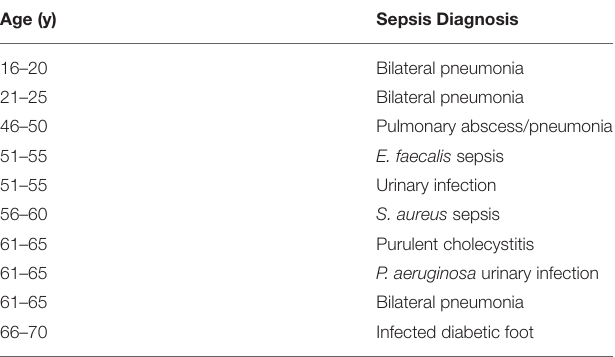
TABLE 4 | Clinical and laboratory findings of 10 patients with septic